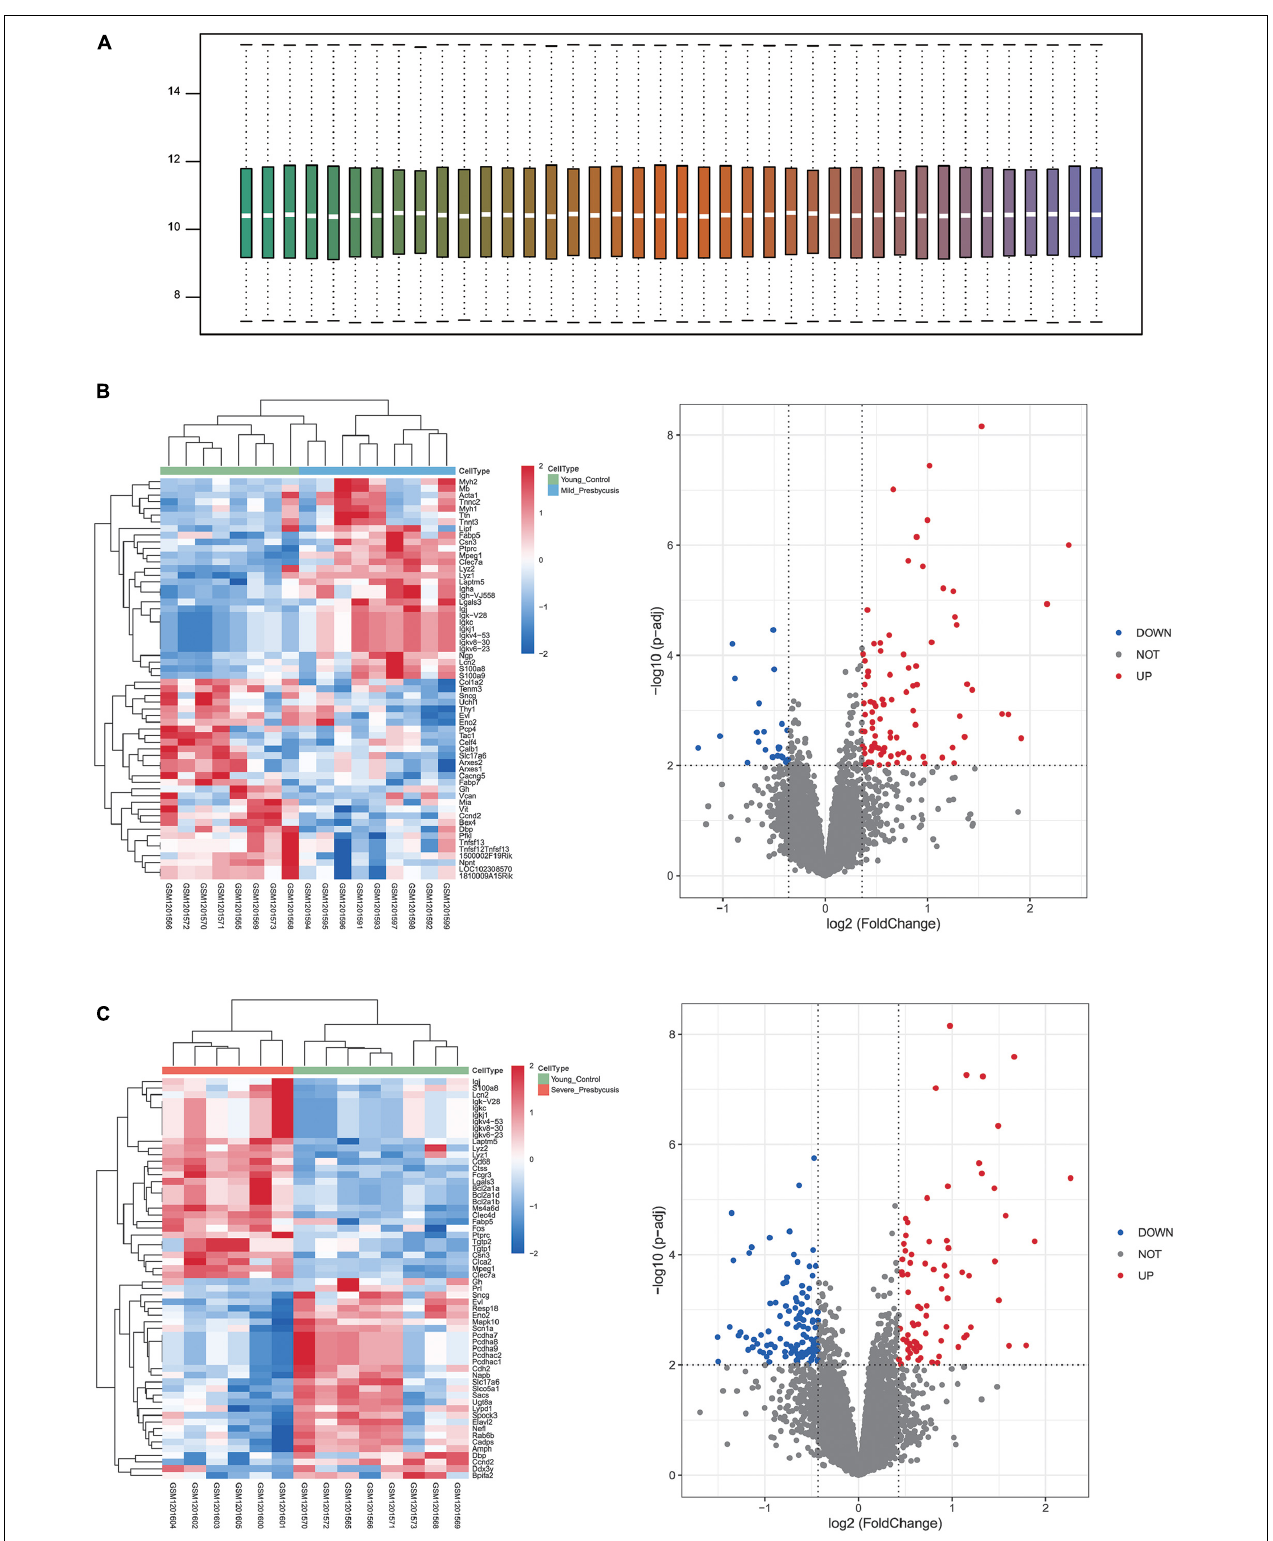
FIGURE 1 | Identification of the differentially expressed genes (DEGs) in presbycusis in GSE49543. (A) Differentially expressed mRNAs data sets were standardized. (B) The heat map and volcano plot of the top 30 up-regulated (red dots) and top 30 down-regulated (blue dots) DEGs in mild presbycusis. (C) The heat map and volcano plot of the top 30 up-regulated (red dots) and top 30 down-regulated (blue dots) DEGs in severe presbycusis.